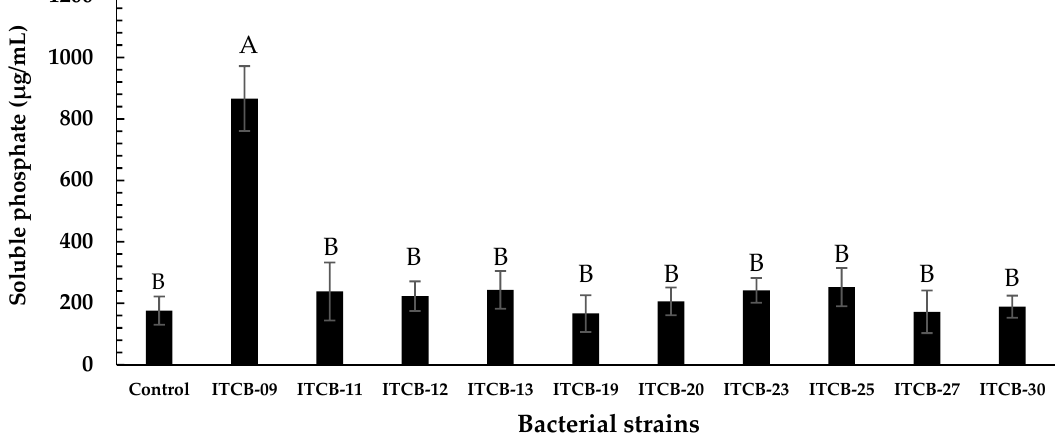
Figure1. Phosphatesolubilizationrateofbacterialstrainsafter15daysonPikovskayabroth. Valueswere Figure 1. Phosphate solubilization rate of bacterial strains after 15 days on Pikovskaya broth. Values the average of at least two determinations. The di ff erent letters on the bars represent significant were the average of at least two determinations. The different letters on the bars represent significant di ff erences ( p < 0.01) based on Tukey’s differences ( p < 0.01) based on Tukey's comparisons.